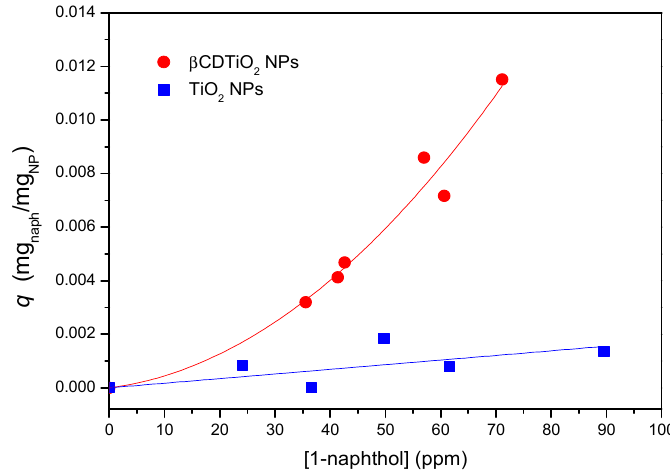
Figure 6. Sorption equilibrium of 1-naphthol data at room temperature corresponding to as-received (blue squares) and β CDTiO 2 NPs (red circles). Trend lines are included for comparison purposes.